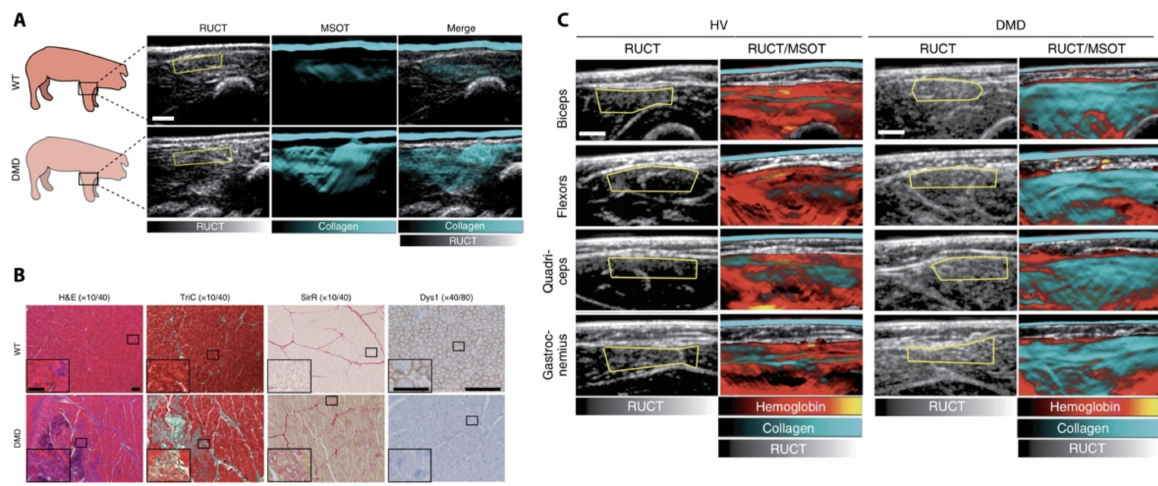
Figure 6. Optoacoustic imaging (OAI) of muscle degeneration in Duchenne muscular dystrophy. ( A ) Shows signals derived from wild-type (WT) and Duchenne muscular dystrophy (DMD) transgenic pigs; ( B ) demonstrates ex vivo tissue changes and expansion of extracellular matrix and collagens in diseased tissues as a possible correlate of OAI signals; ( C ) signals derived from healthy volunteers (HV) and pediatric patients with DMD at different anatomical positions. RUCT and RUCT/MSOT merged images shown. RUCT = reflectance ultrasound computed tomography, MSOT = multispectral optoacoustic tomography. Signals unmixed for hemoglobin and collagen. Figure modified with permission from [94]. This image is not published under the terms of the CC-BY license. For permission to reuse, please see